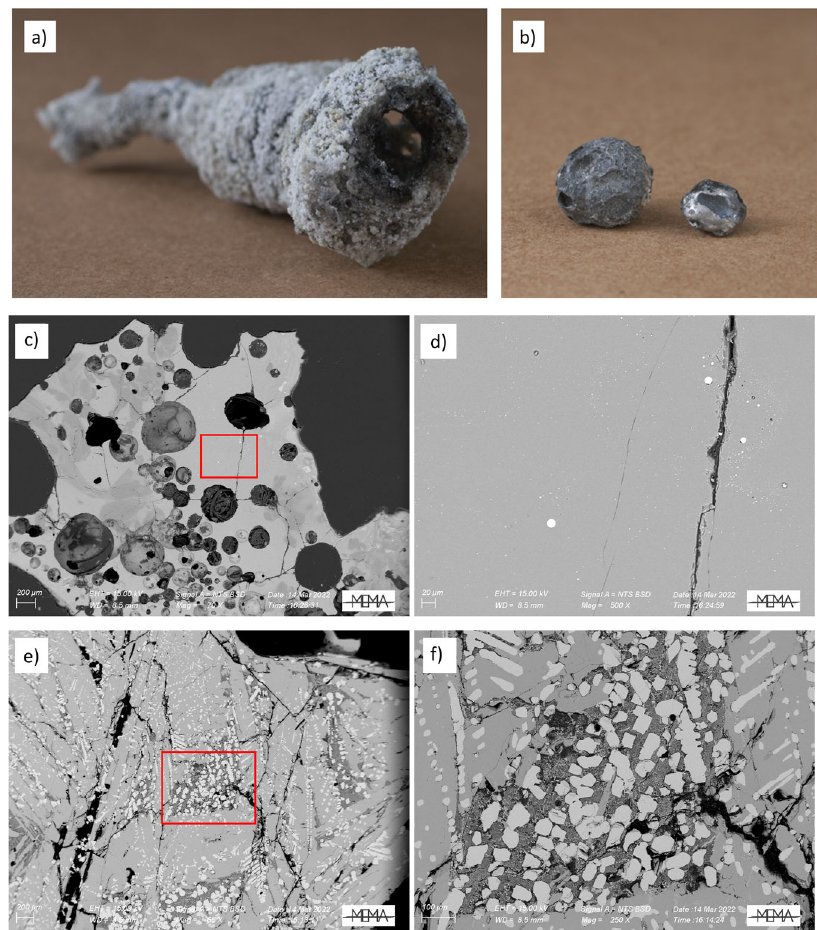
Fig. 1 The New Port Richey fulgurite images and microscopy. a Glassy tubes that consist of a glassy melt surrounding an internal void, in turn surrounded by a crust consisting of cemented sand grains. The diameter of the fulgurite is 2 cm, and length is 7 cm. b Spherules of gray, metallic material within the fulgurite with diameters of 1.1 cm (left) and 0.5 cm (right). c BSE image of the glass of the NPR fulgurite. Varied lithologies of the glass include a darker material (left) composed of SiO 2 , and a lighter material (Ca, Al-rich silicate). Within this glass (red rectangle is the region expanded) are d spherules of iron metal enriched in phosphorus. e BSE image of the large metallic spherules of the NPR fulgurite. These consist of FeSi 2 (medium gray), FeSi (light gray),